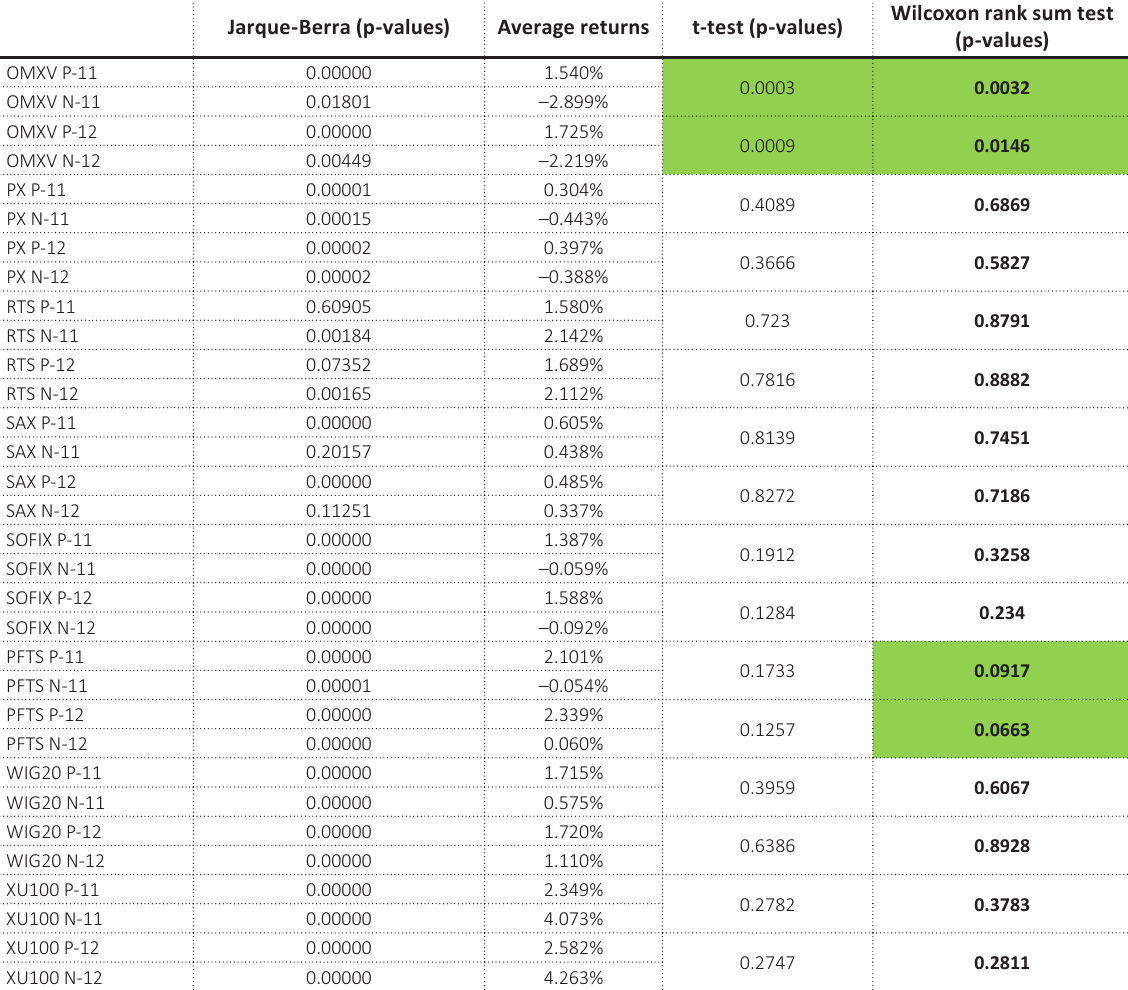
Table 6 (cont.). January barometer statistical significance test results (monthly